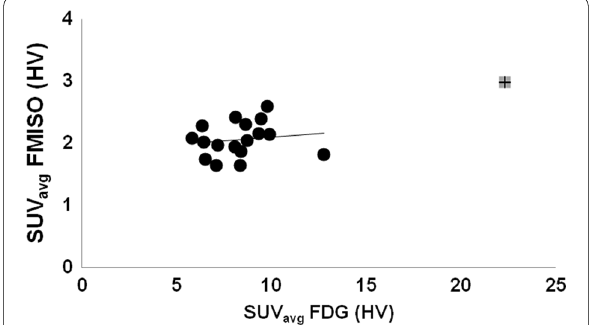
Fig. 2 FMISO vs FDG SUVavg of the primary tumors for the HV (defined by a tumor-to-blood SUV ratio greater than 1.2. A moderate Pearson correlation, R 0.64 (paired t test, P < 0.01), is shown = between the two. The greyed cross data point is an outlier that was excluded from the analysis